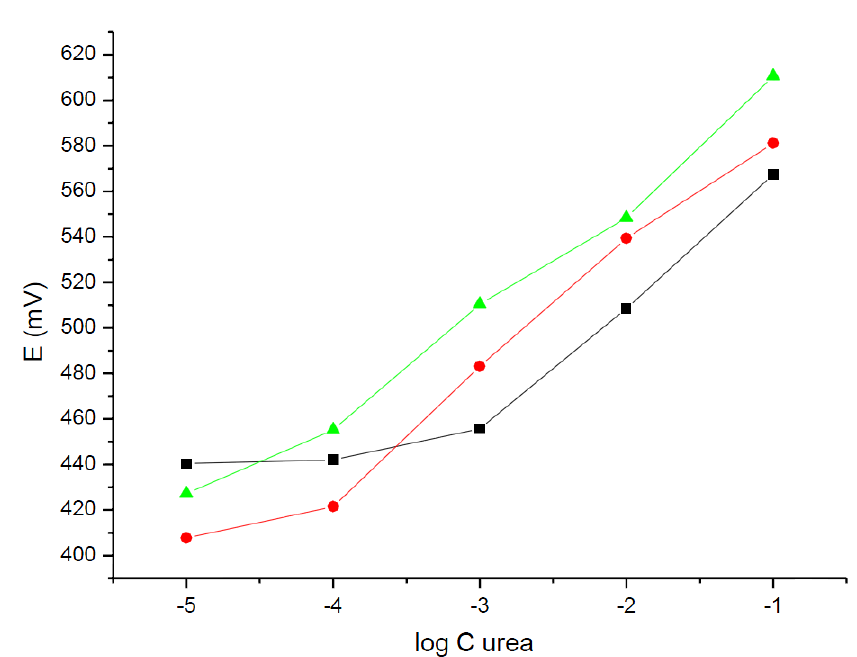
Figure 3. Potentiometric response of urea biosensors based on the ammonium ion-selective carbon-plastic electrodes in (■) 10 −4 M Tris pH = 7.19, (●) H 2 O, and (▲) 0.1 M acetate buffer pH = 5.35